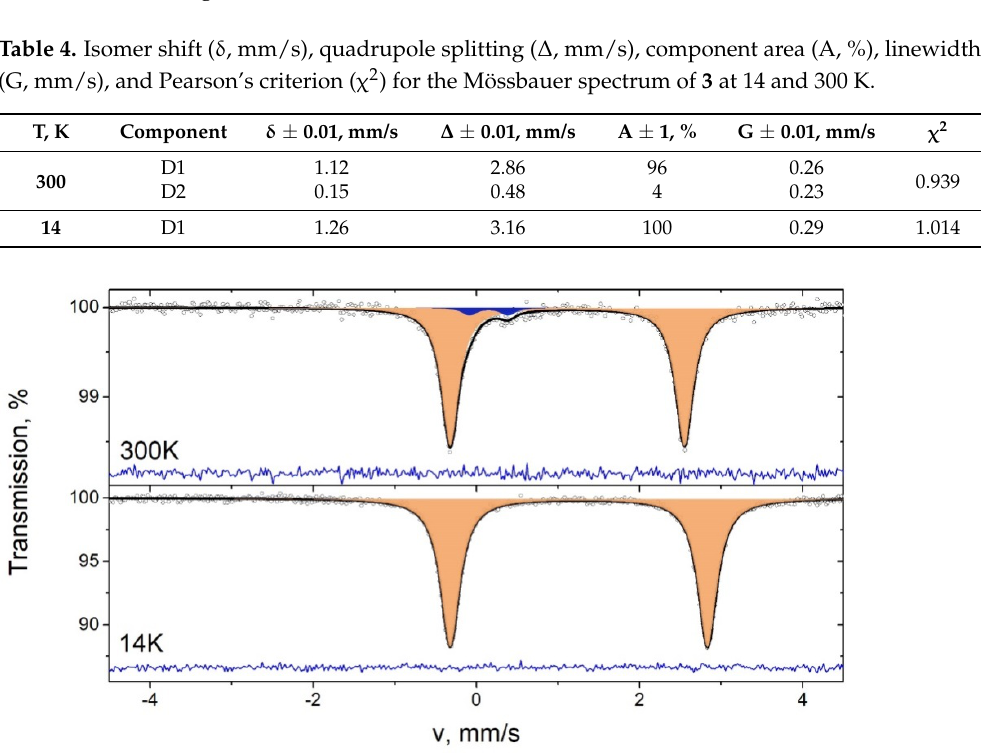
Figure 8. Calculated Mössbauer spectra of 3 at 300 and 14 K (the blue-colored area is for the admixture phase).